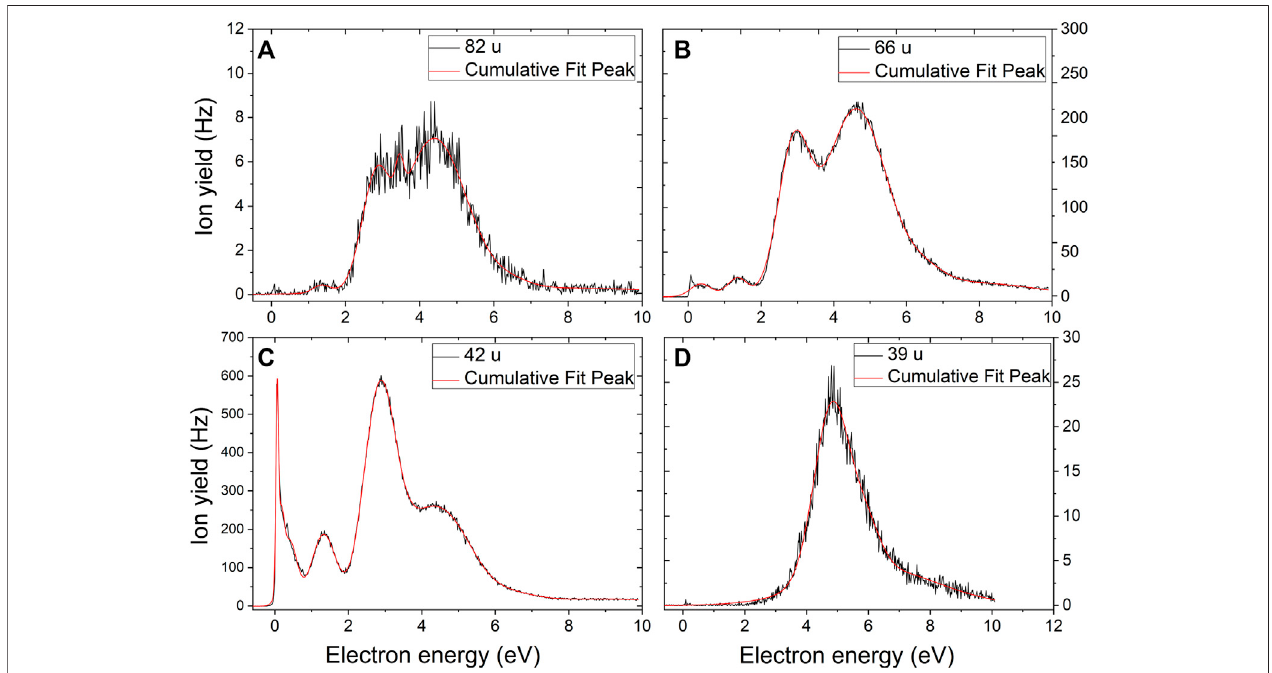
FIGURE 4 | (A – D) Anion ef fi ciency curves for the anions with masses 82, 66, 42 and 39 u formed upon electron attachment to TMZ, respectively.